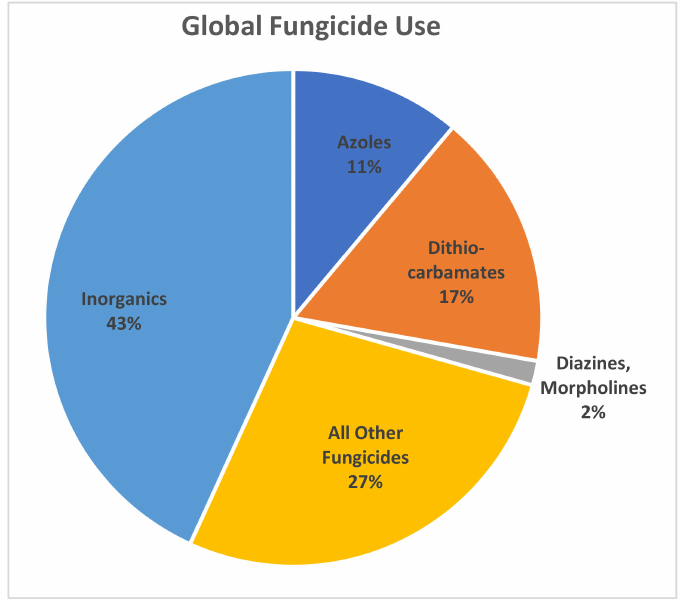
Figure 2. Frequency of use of fungicides globally (created from data in ref